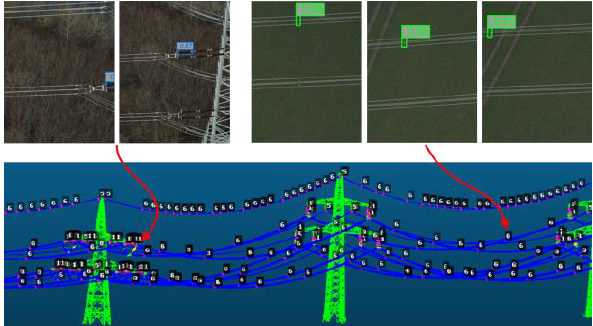
Figure 6. Sample of the digital twin representation showing a semantically segmented 3D point cloud of the infrastructure, detected components and sample images of these